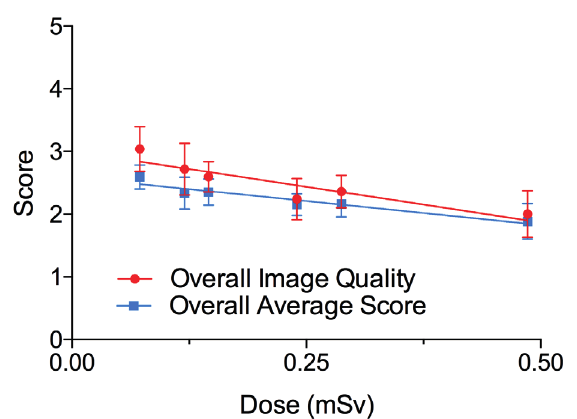
Figure 1. Overall image quality (red circles) and overall average (blue squares) score improved with increased